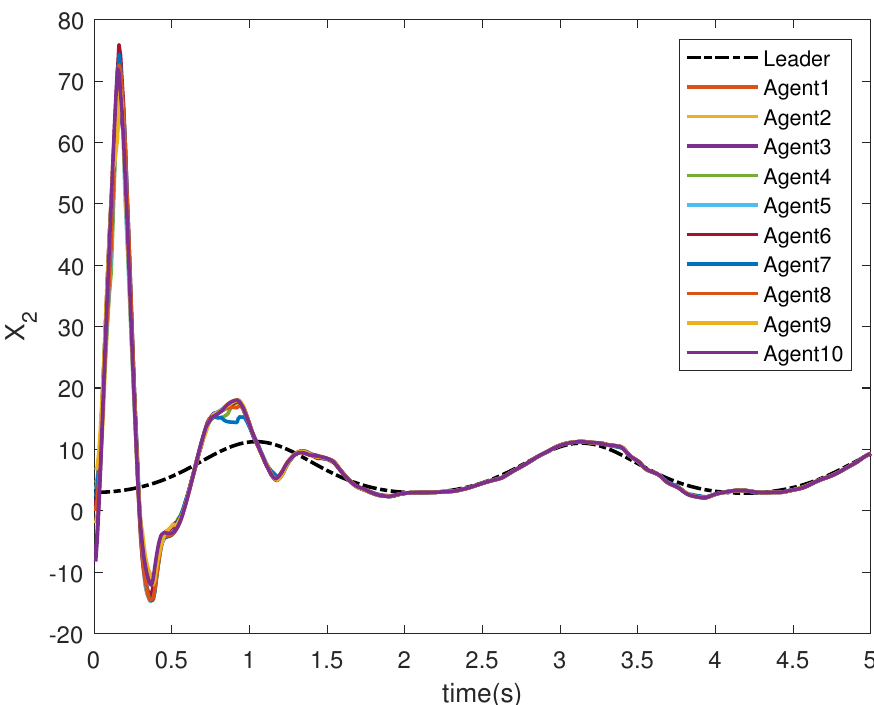
Figure 18. Consensus tracking of state X 2 of the